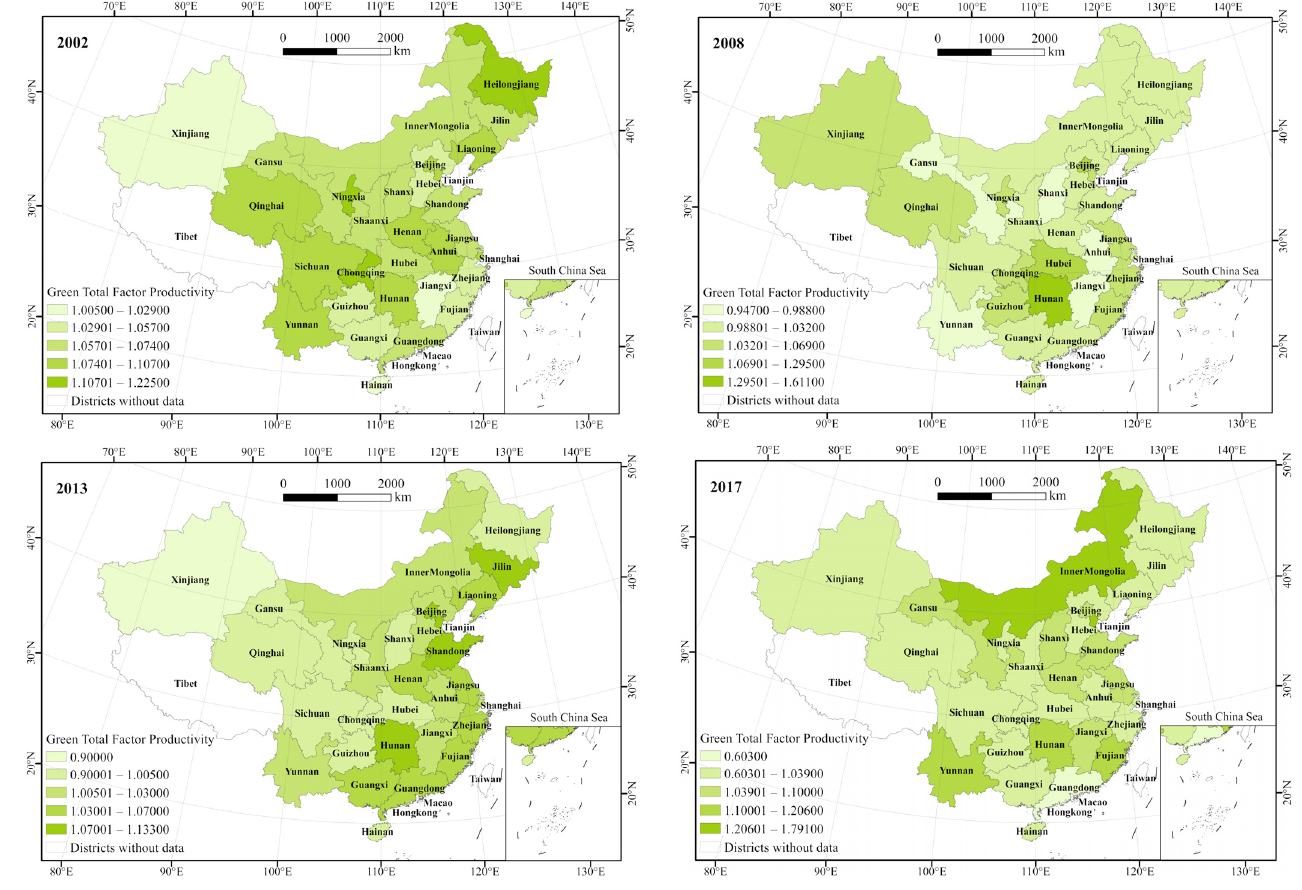
Figure 6. Evolution of the spatial pattern of inter-provincial GTFP in China. Table 4. Shifting direction and distance of center of gravity of inter-provincial GTFP in